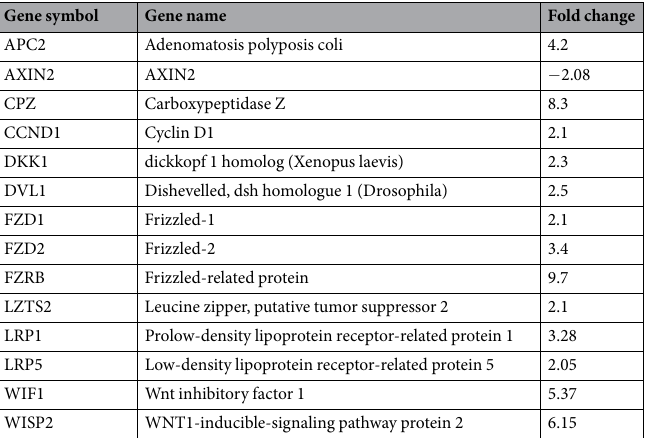
Table 7. List of genes belonging to Wnt signaling pathway that were significantly over expressed between week 1 and 2 (positive value indicates up-regulation at week